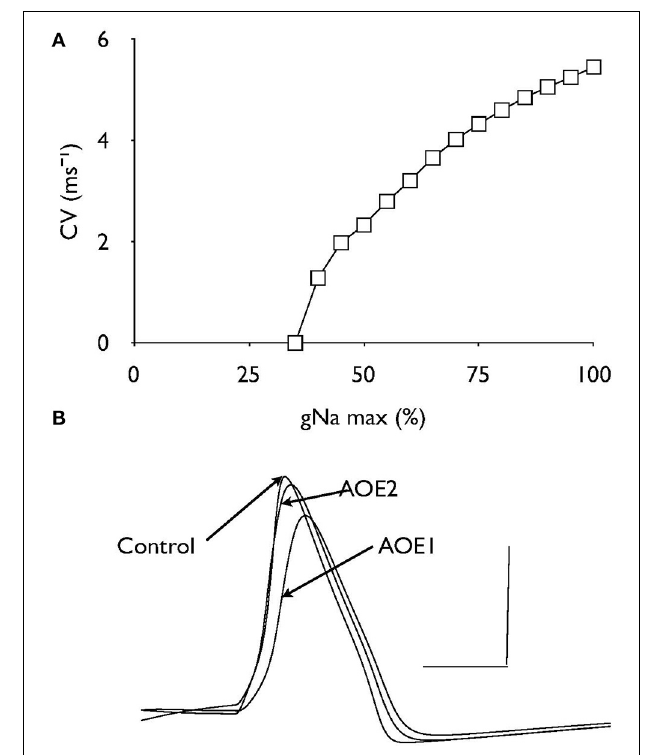
FIGURE 5 | The effect of gNa on conduction velocity. (A) Decreasing the value of gNa relative to the control value as 100% resulted in a non-linear decrease in conduction velocity. (B) Nodal recordings of gL under control and AOE treated conditions. Scale bars 0.01nA and